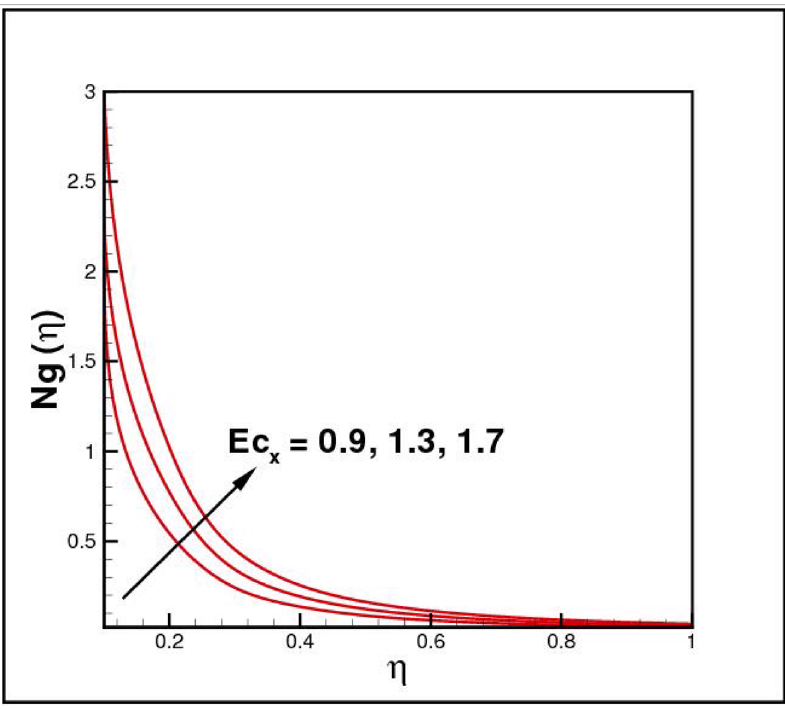
Figure 15. Impact of Ec x on Ng ( η